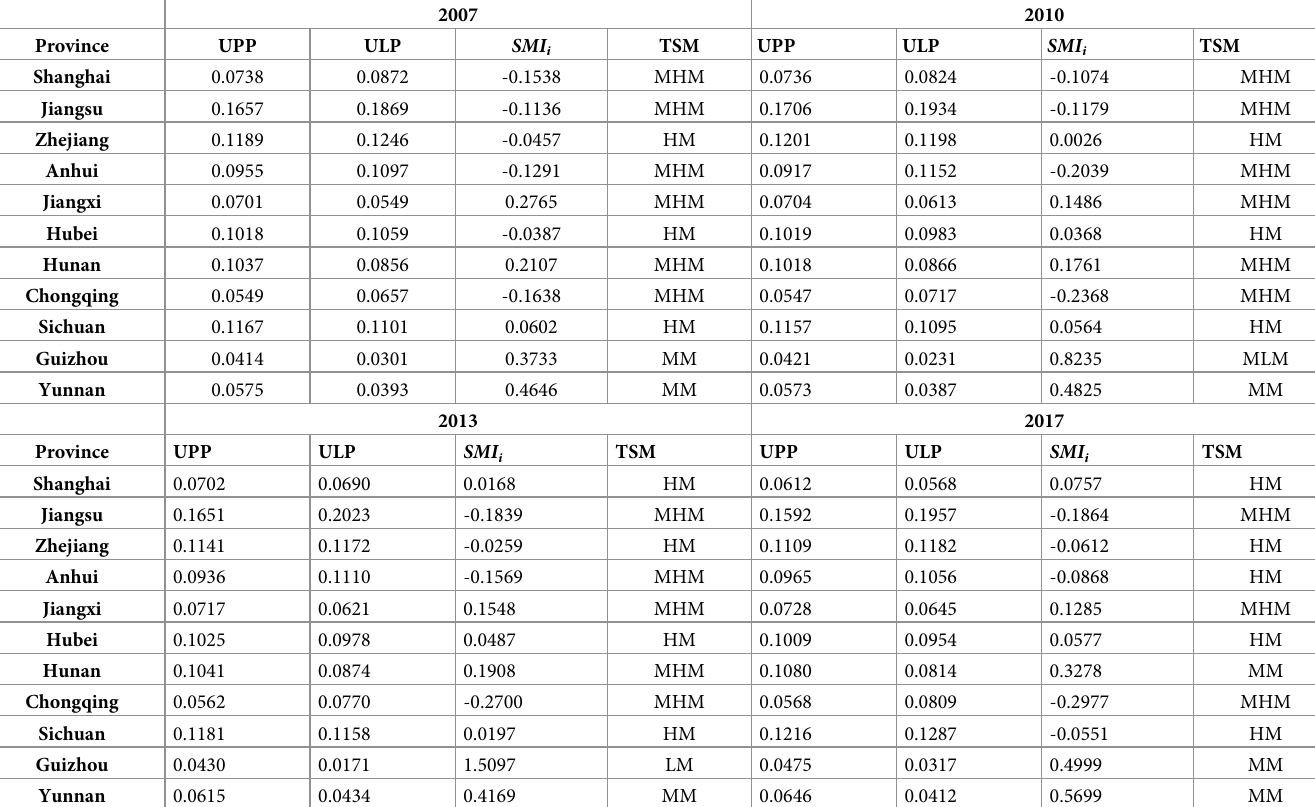
Table 6. Space matching evaluation of the population-land urbanization in the YEB in 2007, 2010, 2013, 2017.